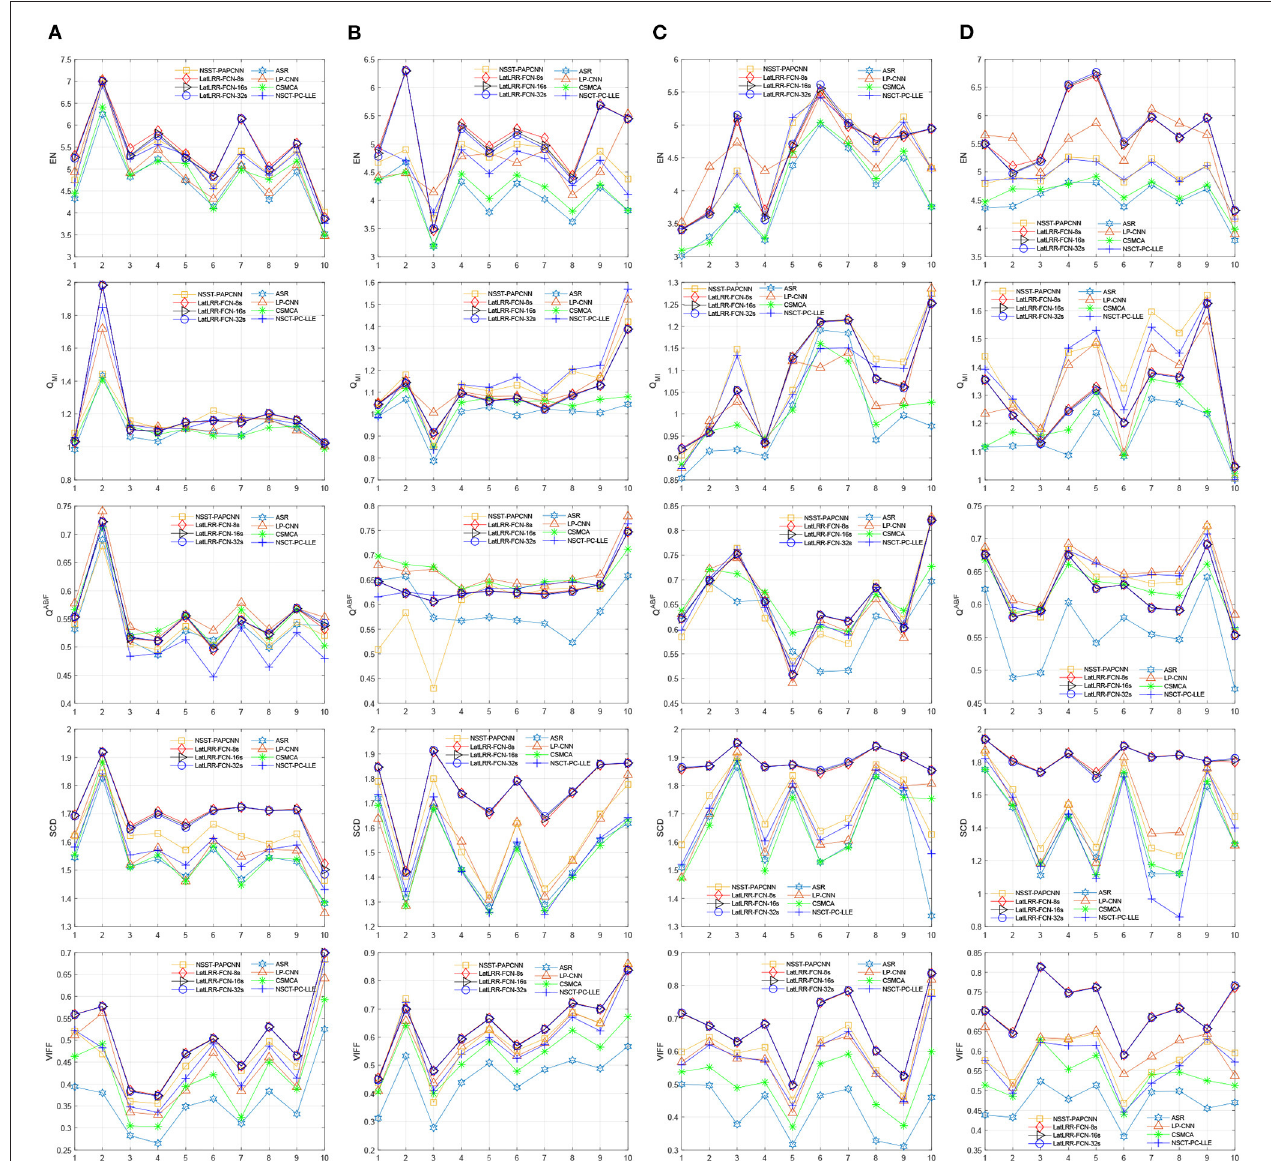
FIGURE 10 | Objective performance of different fusion methods in each fusion problem. (A) CT and MR, (B) MR-T1 and MR-T2, (C) PET and MR, and (D) SPECT and